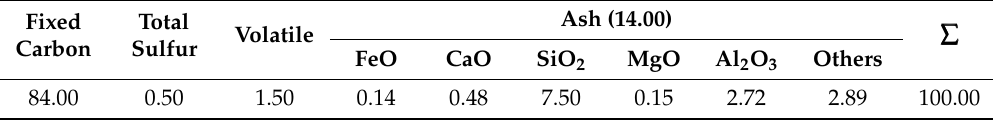
Table 2. Proximate analysis of the coke breeze and the ash composition (wt %).